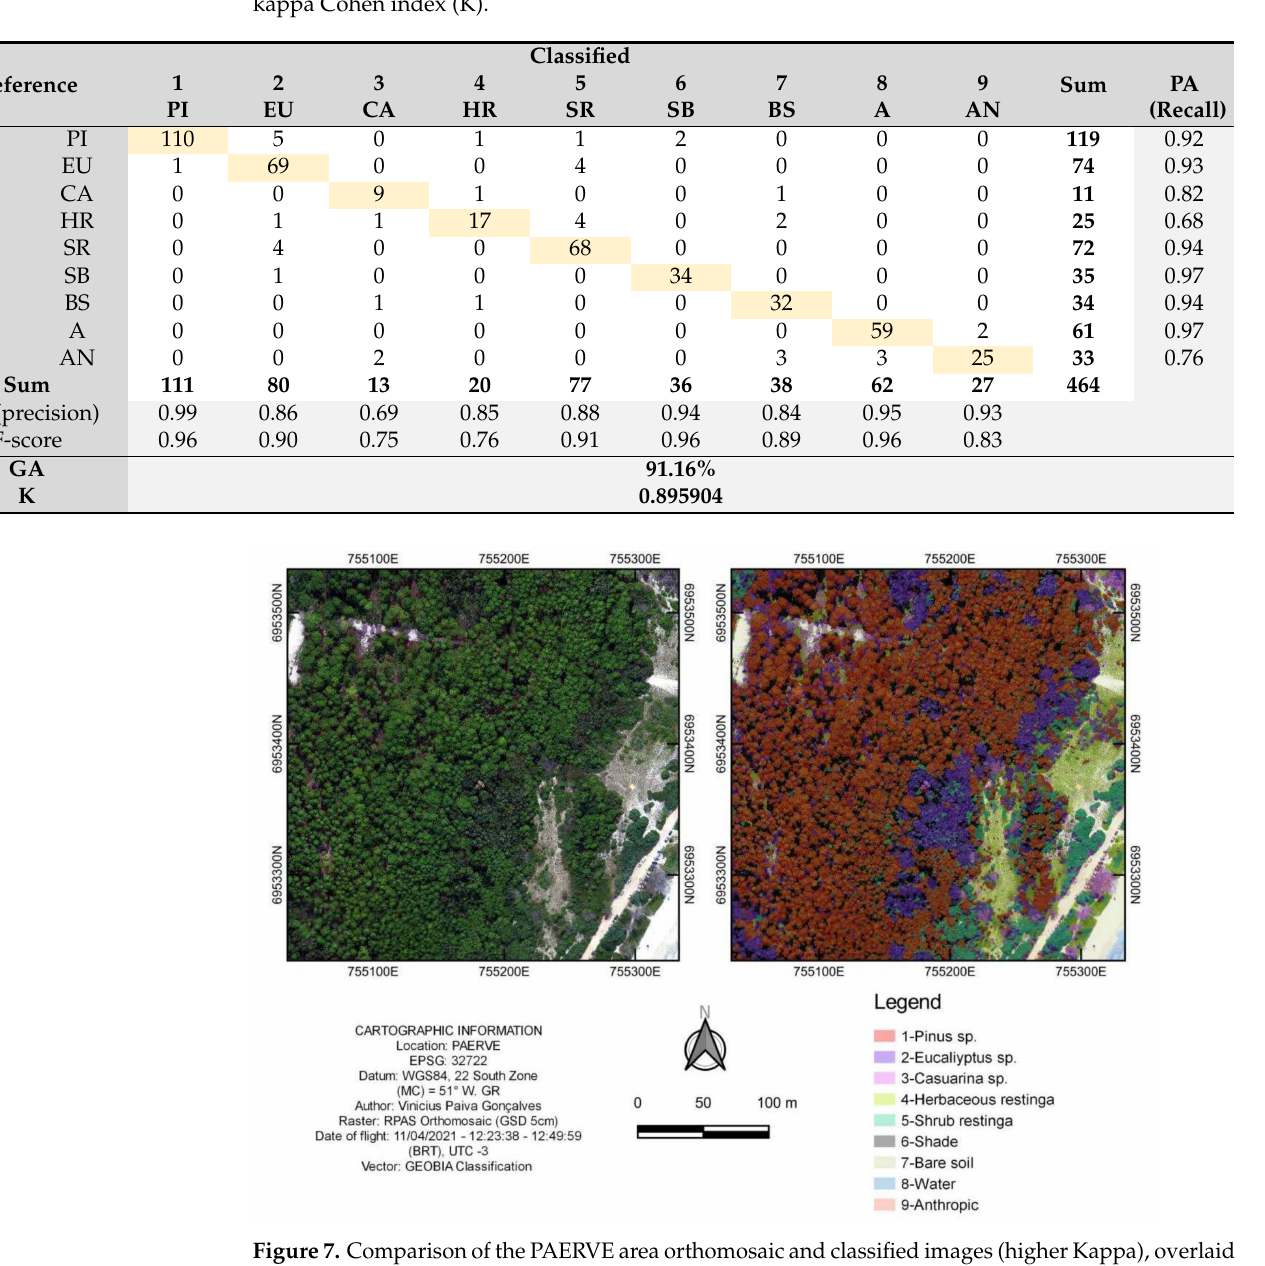
Figure 7. Comparison of the PAERVE area orthomosaic and classified images (higher Kappa), overlaid with 65% transparency. CRS: EPSG 32722. Horizontal datum WGS84, UTM projection system, 22 South Zone. MC 51 ◦ W. GR. Raster: RPAS Orthomosaic (GSD 5 cm). Flight date: 11/04/2021, 12:23:38–12:49:59 Brasilia Time (BRT),